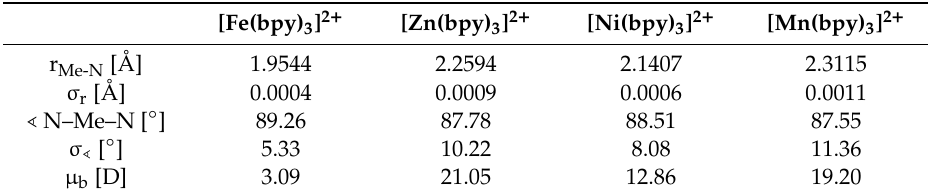
Table 2. The average length of coordinate bonds r Me-N , average values of angles ∢ N–Me–N and dipole moment of coordinate bonds μ b for the optimized structures with values of standard deviations and angles σ . for bonds length σ (cid:2928) ∢